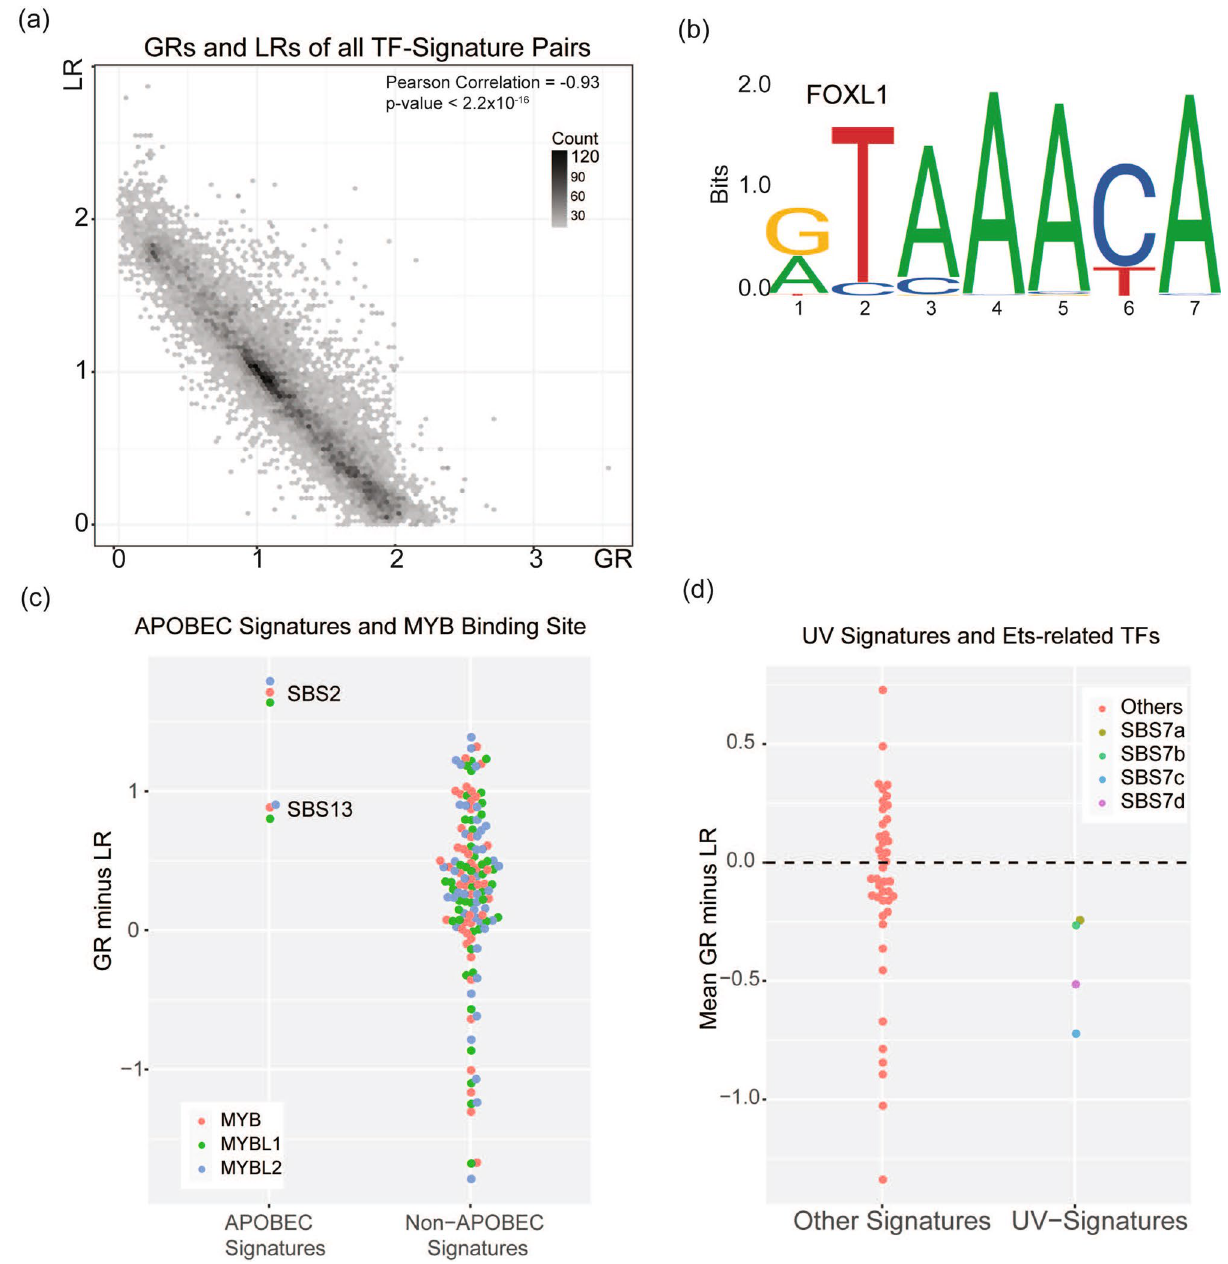
Figure 6. Comparison with the RSAT/PWM approach. ( a ) Unlike RSAT/PWM’s finding of correlation between motif-disruption and motif-creation probabilities, Signature-QBiC GRs and LRs were anti-correlated over all TF-signature pairs. GR, gain ratio; LRs loss ratio. Each dot represents a TF-signature pair. ( b ) FOXL1 PWM logo (downloaded from http://jaspa r.gener eg.net/stati c/logos /svg/MA003 3.2.svg on December 23, 2019). NGC>NTG (GCN>GAN) mutations generating adenines at positions 3, 4 or 7 enhance FOXL1 binding affinity. However, the effects at positions 3 and 4 are relatively weak, while the effect at position 7 is strong, and RSAT/PWM does not take mutations at this position into consideration. ( c ) Like RSAT/PWM, Signature-QBiC supports the finding that APOBEC signatures tend to increase MYB binding. Like the “alteration offset” in Chan et al., GR minus LR captures the difference between the probabilities of a gain of binding and a loss of binding as the result of the mutational signature caused by a particular mutational process. Three TFs with MYB binding sites (MYB, MYBL1 and MYBL2) represented by PBM experiments M01855_1.94d, M01856_1.94d and M01854_1.94d, respectively. ( d ) Signature-QBiC supports Chan et al.’s conclusion that UV signatures (SBS7a, SBS7b, SBS7c and SBS7d) tend to disrupt binding of ETS-TFs. “Mean GR minus LR”, which is the mean value of GRs minus LRs of 28 TFs, is analogous to “mean differential alteration probability” in Chan et al.’s analysis. This analysis comprises 28 ETS-family TFs represented by 29 PBM experiments (details in Table